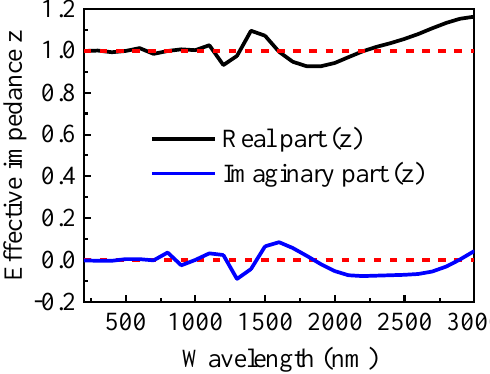
Figure 3. The effective impedance (Z) of the perfect absorber. To thoroughly understand the absorption mechanism of the designed absorber, we selected five representative wavelengths, namely, 200, 500, 1000, 1800, and 2300 nm, and then investigated the electric field |E| and magnetic field |H| profiles in the x-z plane for y = 0 nm in Figures 4 and 5, respectively. From Figure 4a, one can see that the local electric field is largely distributed on both sides of the top of the pyramidal structure at the wavelength of 200 nm. The electric field intensity located at the top of the pyramid structure gradually moves to the bottom, when the incident wavelength varies from 500 to 2300 nm (Figure 4b − e), and the electric field intensity gradually enhances with the increase of wavelength and fills the interspace of two nearby pyramid structures. Hence, the electric field is largely focused on the edge and the bottom corner of the Ti pyramid structure. The main reason for producing the localized strong field is the excitation of the localized surface plasmon resonances (LSPR) on the Ti pyramid [35–37]. Additionally, the electric field in the air gap between two adjacent unit cells is also significant due to the coupling between the two neighboring LSPR modes. Similarly, as can be observed from Figure 5, at a shorter wavelength, such as λ = 200 nm, the magnetic field is localized at the top part of the pyramid. As the incident wavelength increases, the distribution of magnetic field slowly moves down, which is similar to the change trend of the electric field. With the evolving widths from top to bottom, the pyramid can support resonances at different wavelengths, and the overlap of these resonances leads to a wideband enhanced resonant